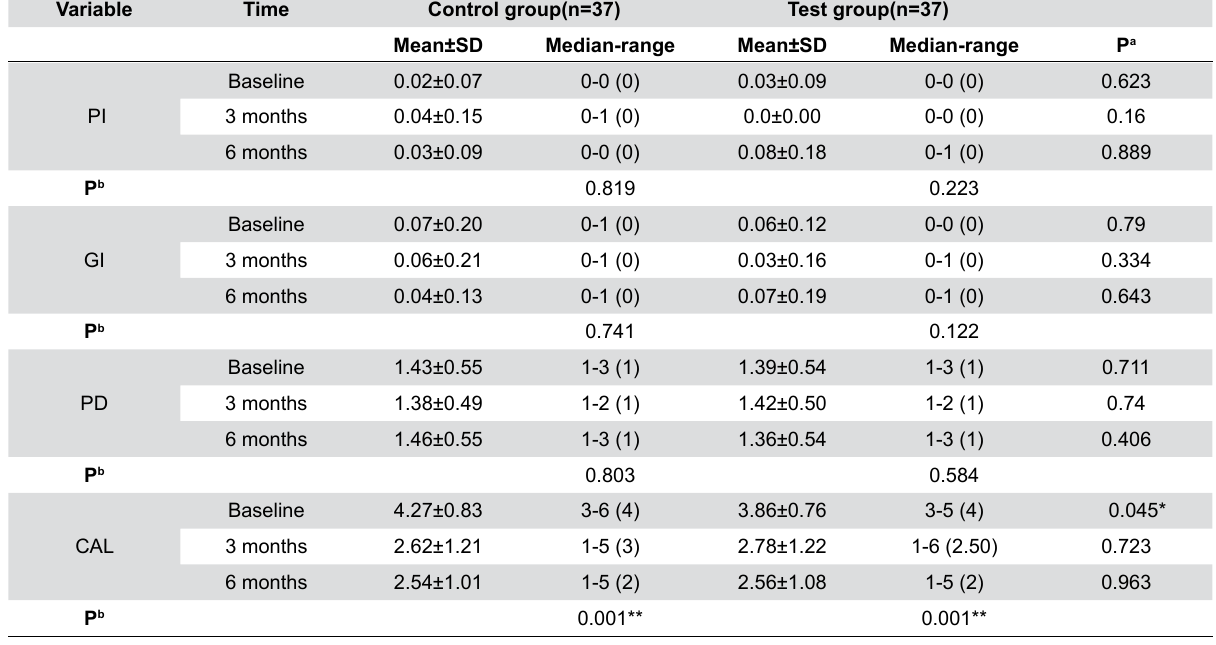
Table 1- Evaluation of PI, GI, PD and CAL clinical parameters and comparisons